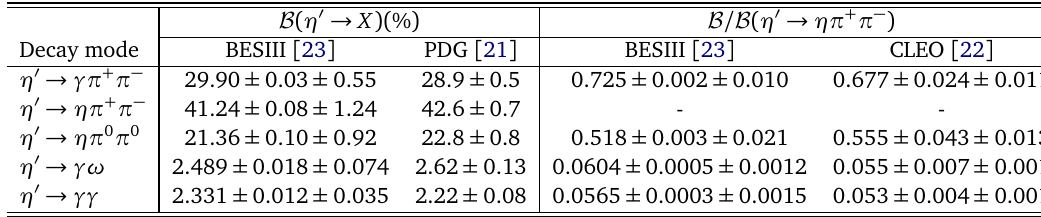
Table 1: Summary of the measured BFs for η (cid:48)